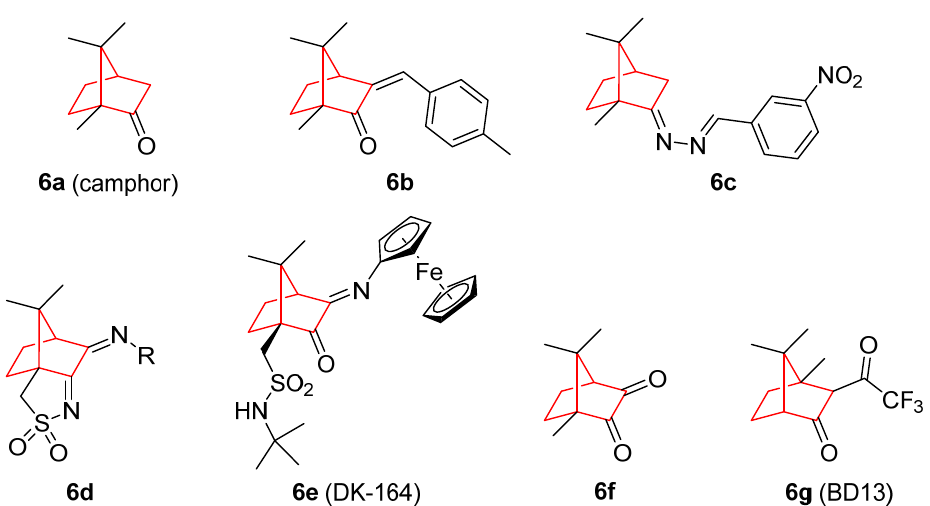
Figure 6. Camphor [54–57] and several other derivatives with antitumoral activity [58–64].